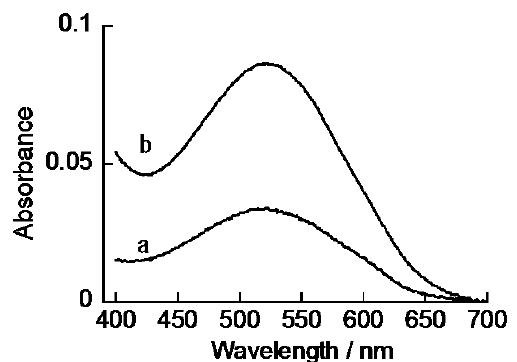
Figure 2. UV-visible spectra of ARS-immobilized (PEI/CMC) 5 PEI ( a ) and (PEI/CMC) 10 PEI films ( b ). The spectra were recorded by immersing the LbL film-coated quartz slides in 10 mM HEPES buffer (pH